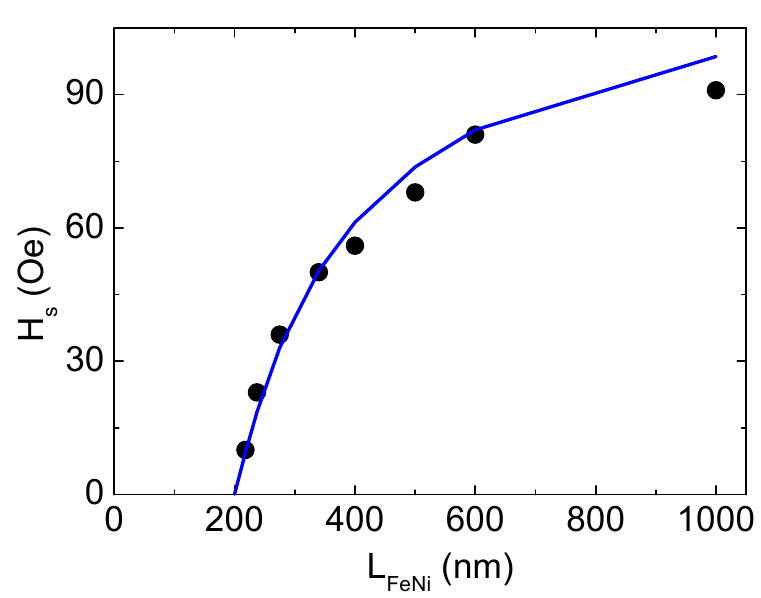
Figure 5. ( a ) hysteresis loops for FeNi(180 nm) film measured along (1) and perpendicular (2) to the easy axis magnetization; ( b ) hysteresis loops for FeNi (340 nm) film both in initial state and after separation from the substrate and annealing at 300 °C during one hour; ( c ) MOKE image of the stripe magnetic domain structure for FeNi (220 nm) film.